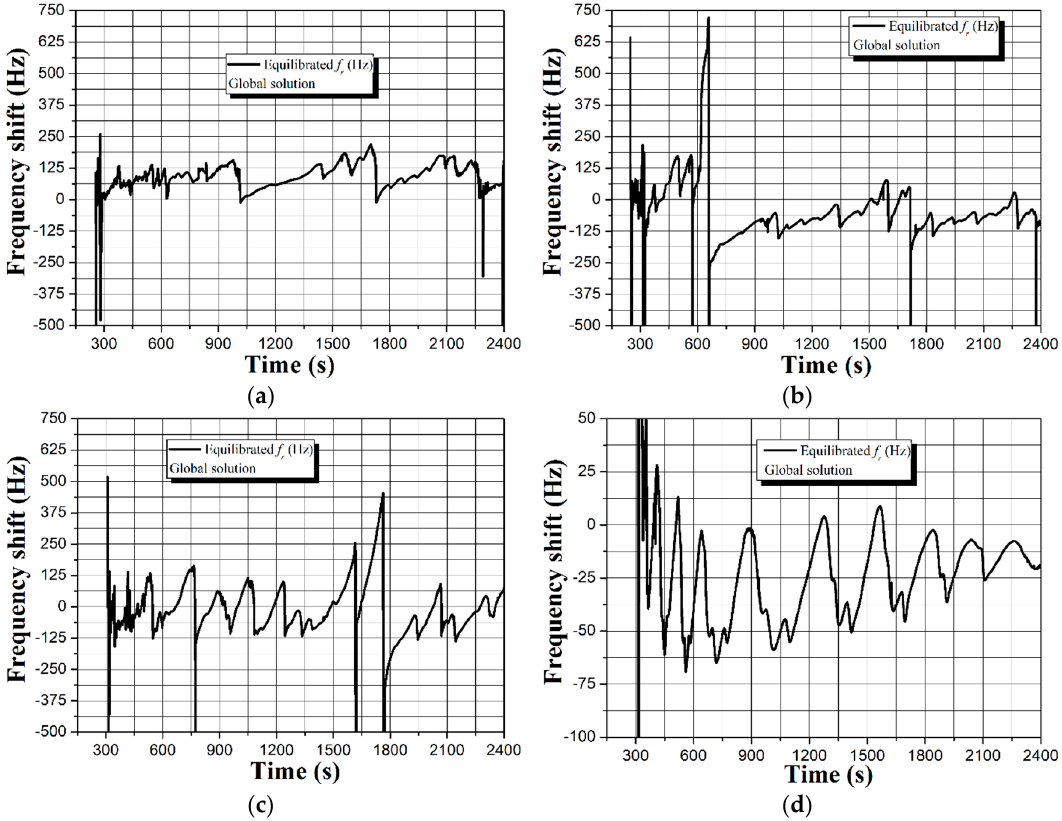
Figure 4. Fragmented frequency shifts for an uncoated 5 MHz QCM before adding ( a ) HSA and immotile spermatozoa at 1st measurement (part of Figure 2a), ( b ) HSA and immotile spermatozoa at 2nd measurement (part of Figure 2c), ( c ) immotile spermatozoa at 1st measurement (part of Figure 3a), and ( d ) motile spermatozoa at 1st measurement (part of Figure 3c). The full spectral profiles, i.e., those with mass displacement and resistance shifts can be found in Figures S3–S5 in the supporting information.